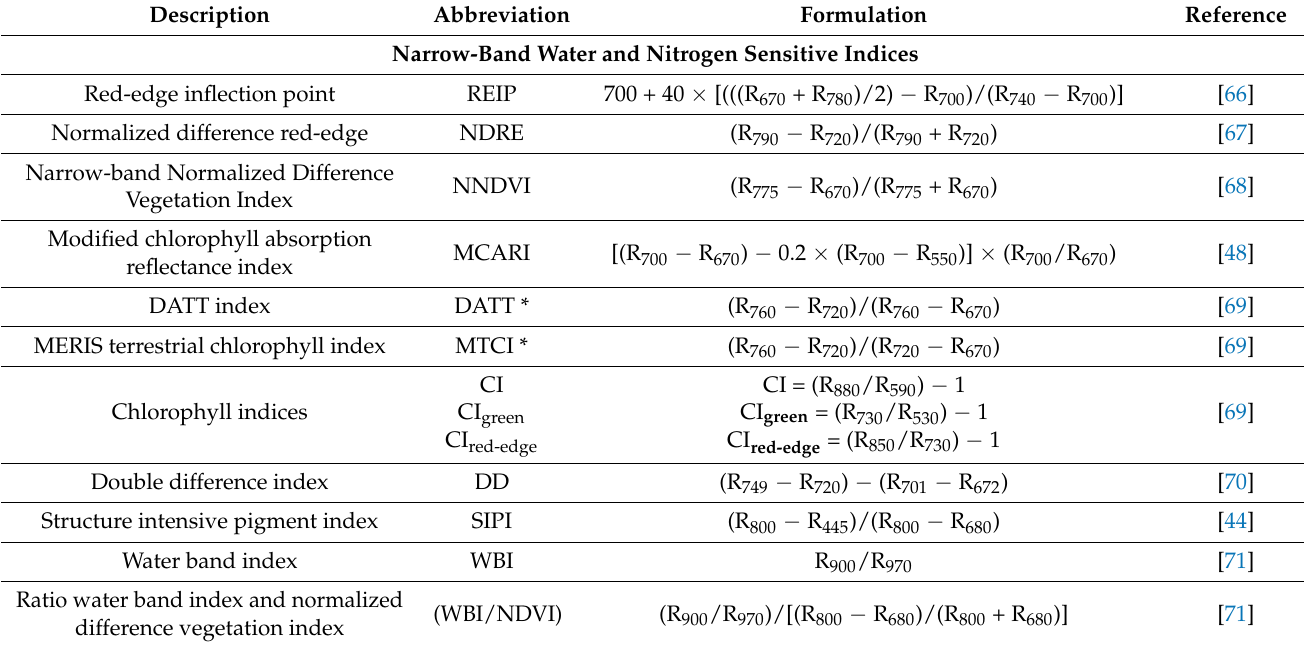
Table 1. The indices derived from the hyperspectral visible and near-infrared